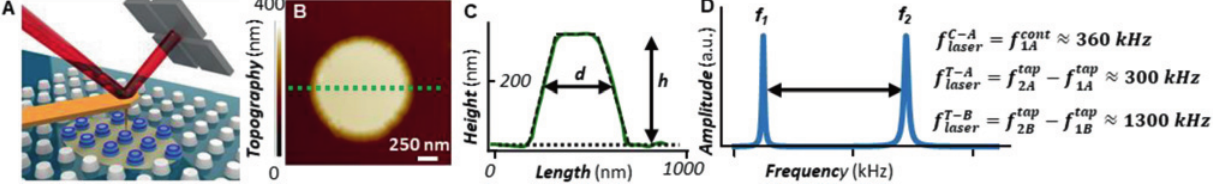
Figure 1: (A) PTIR schematic. A pulsed tunable IR laser illuminates the portion of the sample (region highlighted in yellow centered around gold-coated AFM probe). (B) AFM topography image of a hBN frustum with Ar 1 = 4.65 ± 0.11 (sample-1). (C) AFM topography line pro fi le corresponding to the green line in panel-B, showing the results of the fi tting for determining the frustum dimensions. (D)